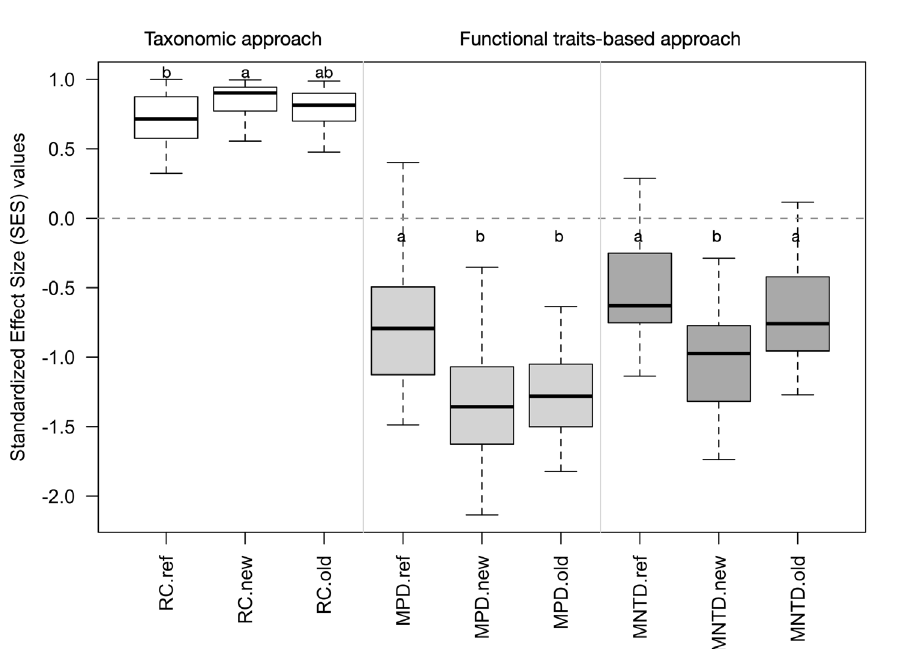
FIGURE 3 | Standardized effect sizes for each taxonomic and functional turnover metric (mean and 95% confidence intervals). RC = Raup-Crick; MPD = mean pairwise distance; MNTD = mean nearest taxon distance; ref = streams with forested watersheds; new = streams with recently deforested watersheds; old = streams with historically deforested